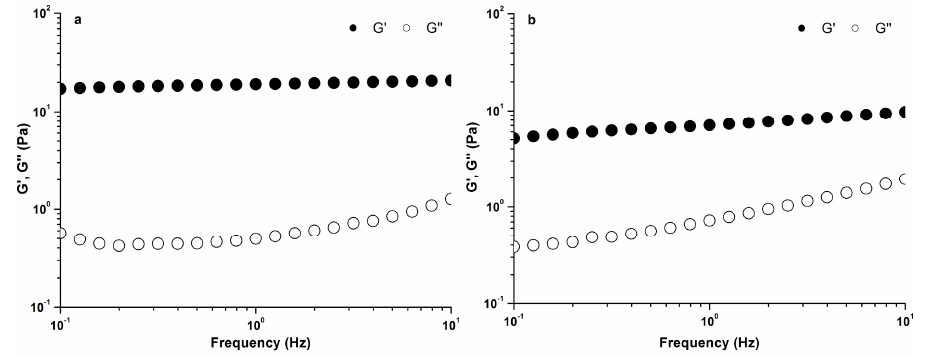
Figure 5. Mechanical spectra showing variation of G ′ and G ″ with frequency of 1.0% PLAP with 0.2 M Ca 2+ ( a ) or 0.2 M Na + ( b ).